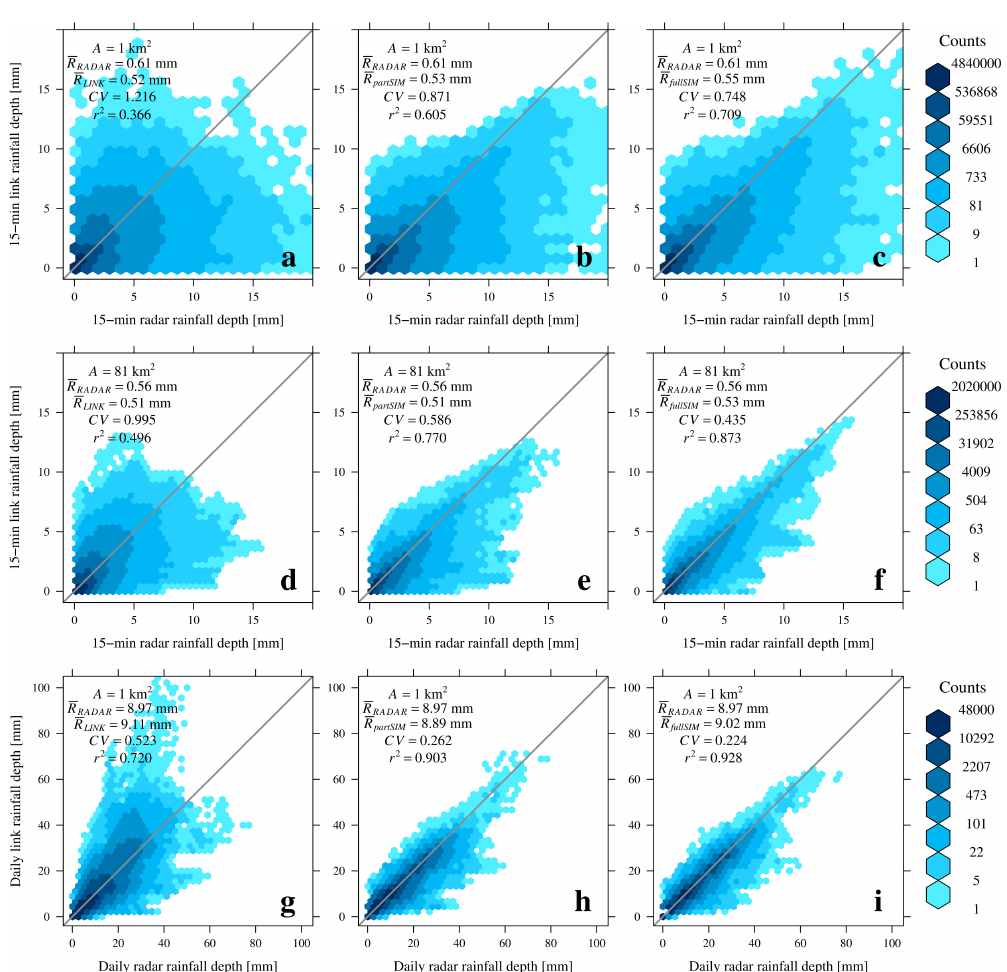
Figure 4. Scatter density plots of interpolated link rainfall depths vs. radar rainfall depths for 15min and 24h. Top row (a, b, c) : 15min rainfall depths; middle row (d, e, f) : 15min rainfall depths averaged with the surrounding pixels within a 9 × 9 pixel square; bottom row (g, h, i) : daily sum of 15min rainfall depths. Left column (a, d, g) : actual link rainfall maps vs. radar rainfall fields; centre column (b, e, h) : simulated link rainfall maps (actual availability) vs. radar rainfall fields; right column (c, f, i) : simulated link rainfall maps (100% availability) vs. radar rainfall maps. (d) and (g) are comparable to Overeem et al. (2013). The colour scale is